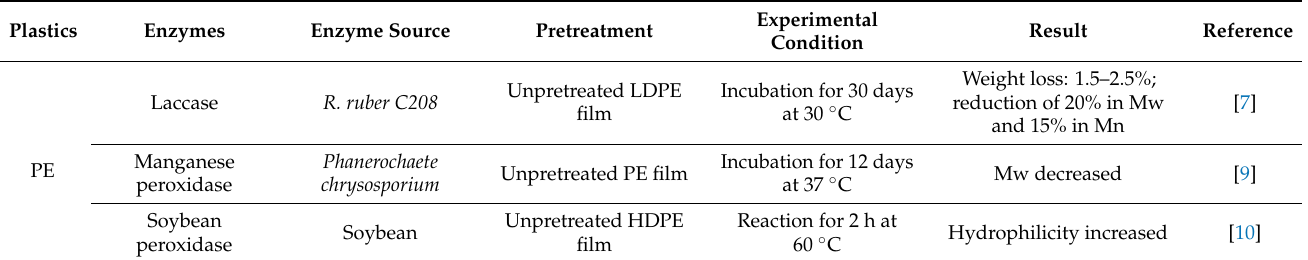
Table 3. Enzymes capable of polyolefin